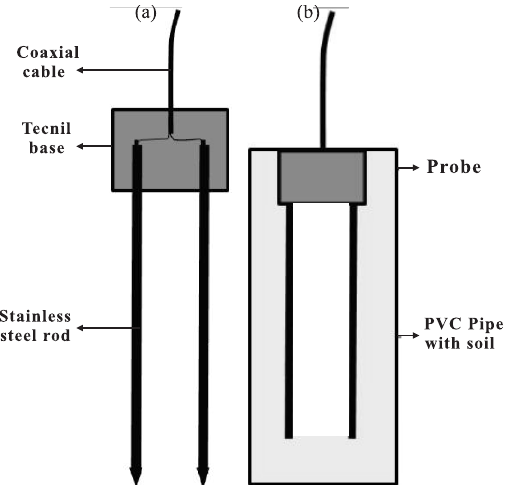
equation.Figure 1. TDR probe and installation setup used. (a) details and (b) probe inserted into a soil